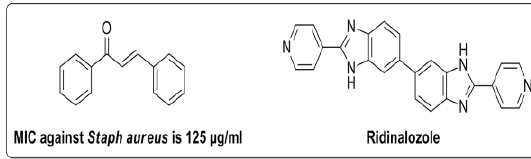
Fig. 1 . Simple chalcone exhibiting good MIC against S. aureus and